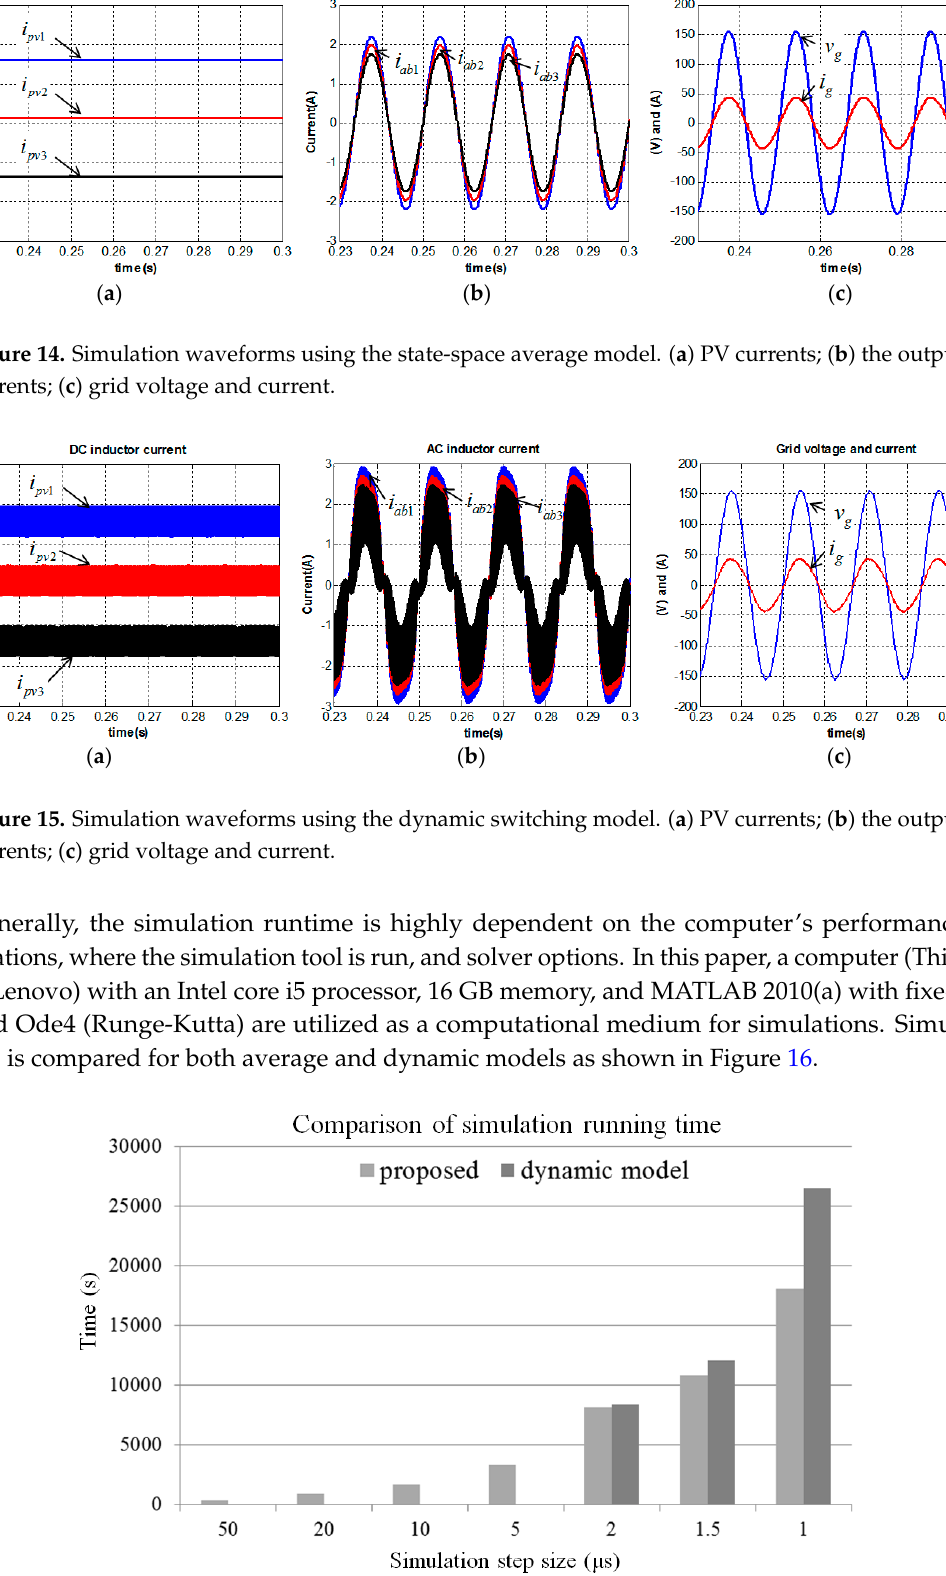
Figure 16. Comparison of the simulation runtime